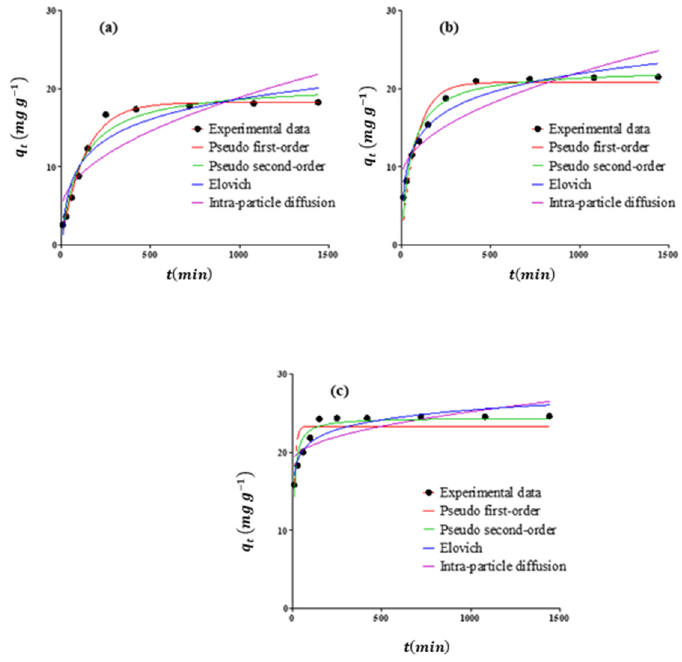
Figure 8. Pb(II) adsorption kinetics by ( a ) RS, ( b ) RSAC, and ( c ) nZVFe–RSAC.